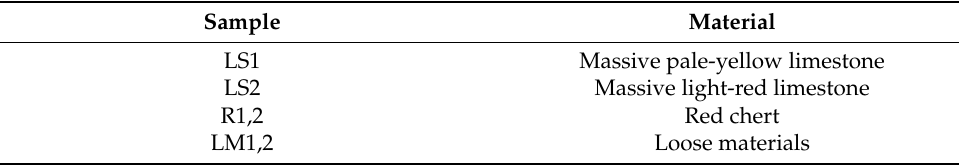
Table 4. Groups of collected rock